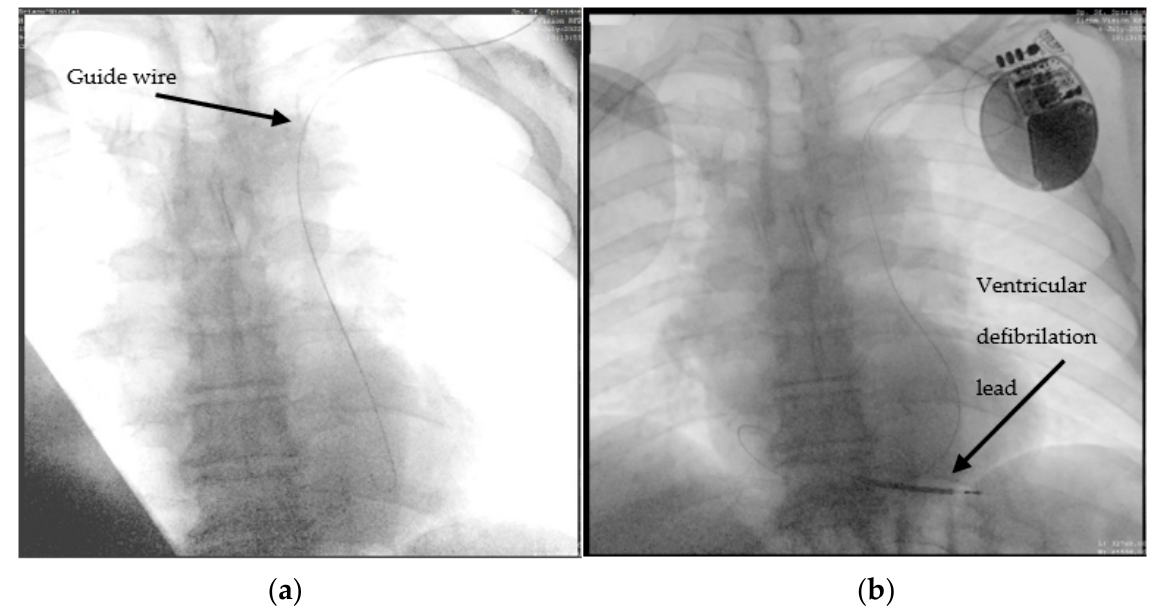
Figure 2. Advance of the ICD ventricular lead through persistent left superior vena cava, coronary sinus, right atrium, and finally, the right ventricle: ( a ) the guide wire (marked) descending to the left side of the spine; ( b ) the ventricular lead placed through the left SVC and coronary sinus into the RV.